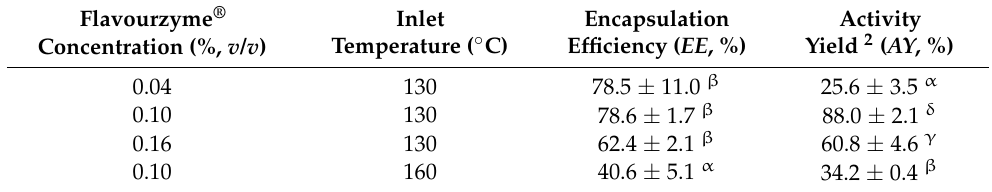
Table 2. Effect of enzyme concentration and inlet temperature on the retention of protease activity in spray-dried chitosan–TPP microparticles 1 .